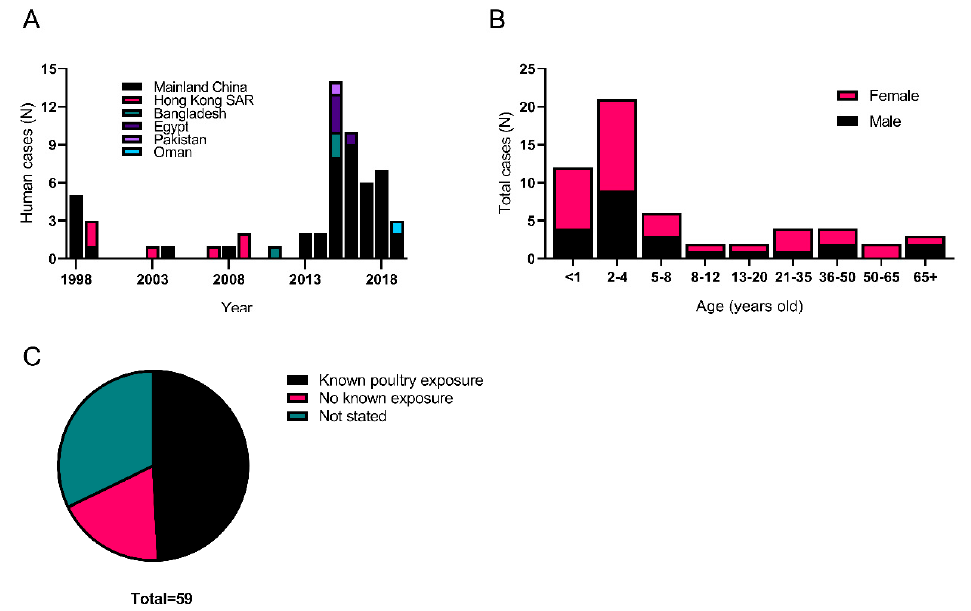
Figure 2. Distributions of human cases of H9N2 infection. ( A ) Laboratory confirmed cases over time and per country. ( B ) Age and Sex distribution of H9N2 infections. ( C ) Poultry exposure status of human H9N2 cases. Table 2. Laboratory confirmed human cases of H9N2 infection.